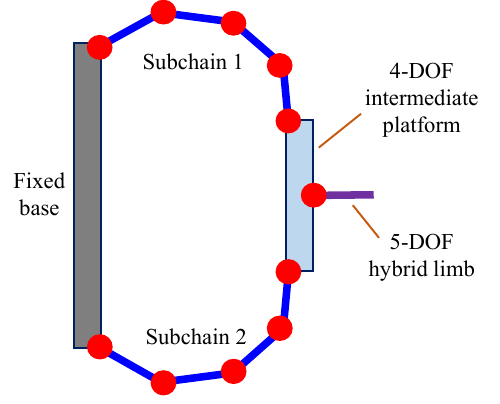
Figure 2. Structure of the hybrid limb. 4-DOF PMs usually output three kinds of motion, i.e., 3R1T motion, 2R2T motion, and 1R3T motion. All three kinds of motion are considered here. Since each PM is composed of two identical hybrid limbs, the constraint generated by the hybrid limbs can be obtained as follows: (a) for a PM with 3R1T motion, each hybrid limb has one constraint force, and the two constraint forces intersect at a common point, which restricts two translational DOFs of the moving platform; (b) for a PM with 2R2T motion, each hybrid limb has one constraint force, and the two forces are parallel with each other, which restricts a rotational DOF and a translational DOF; (c) for a PM with 1R3T motion, each hybrid limb generates one constraint couple, and the two constraint couples restrict the two rotational DOFs of the moving